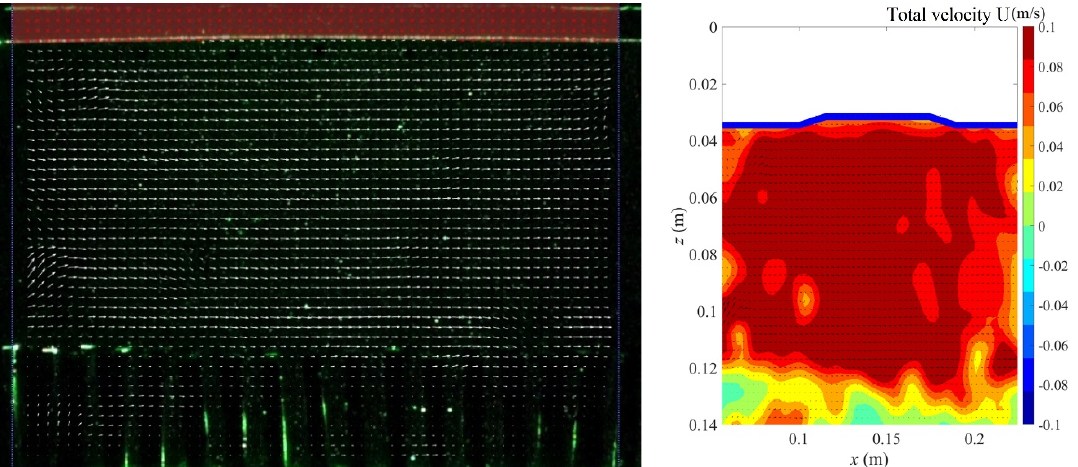
Figure 16. Velocity field and distribution of a long-period wave crest ( T = 2.0 s) passing through vegetation structures ( ϕ = 0.5 cm and d = 5 cm).